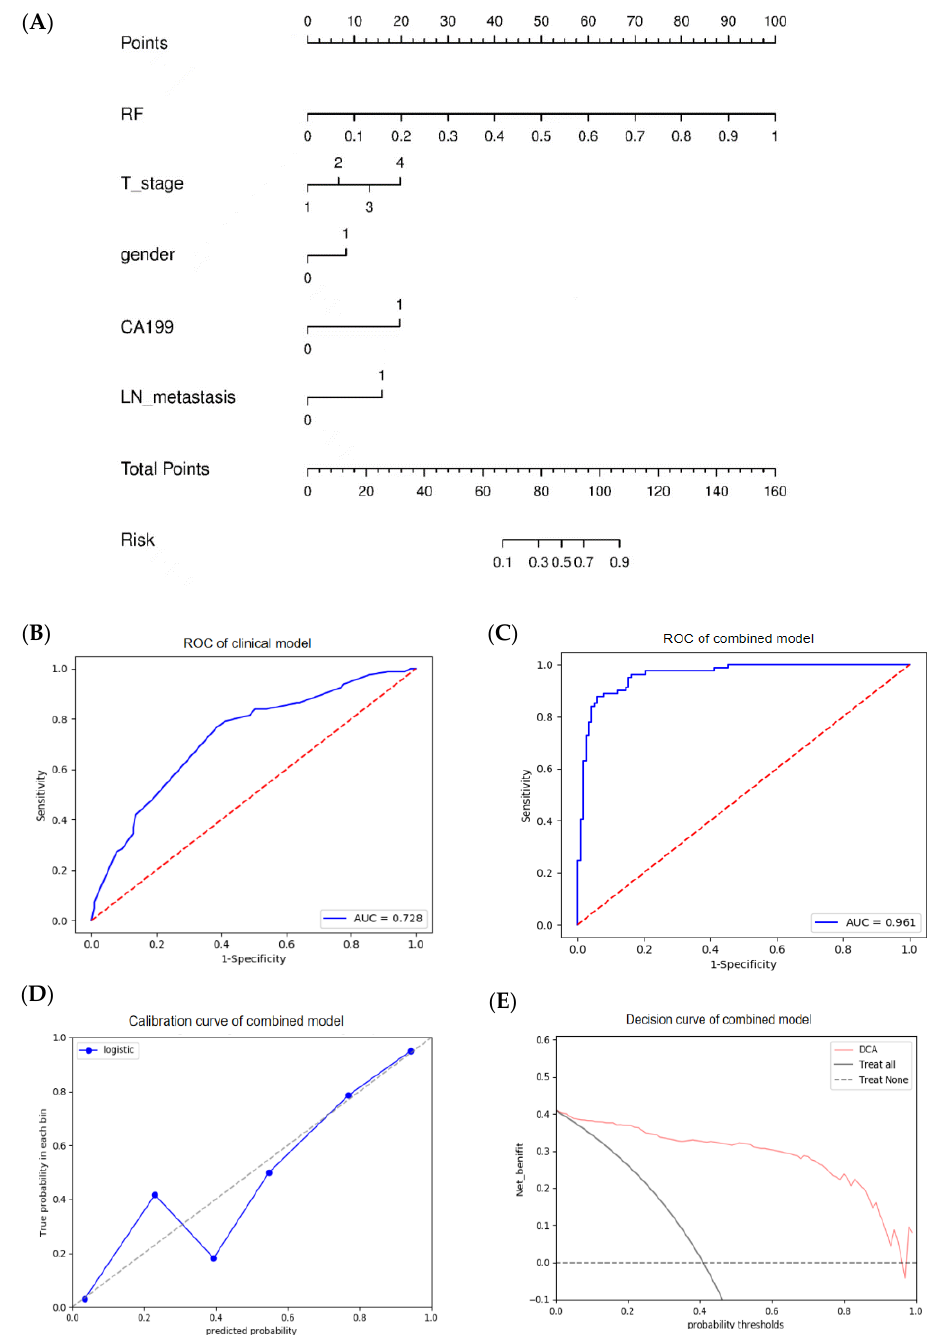
Figure 8. Construction of clinical and combined model in the internal training group. ( A ) A nomo- gram was visualized by integrating the best radiomics model-RF and screened clinical features including T stage, gender, CA199, lymph node metastasis. The clinical model ( B ) and combined model ( C ) achieved the modest and the best diagnostic performance, respectively. ( D ) The calibration curve of the nomogram presented a good consistency between predicted and observed histological grade. ( E ) The decision curve of the nomogram provided the best diagnostic efficacy over and above the “treat all” or “treat none”